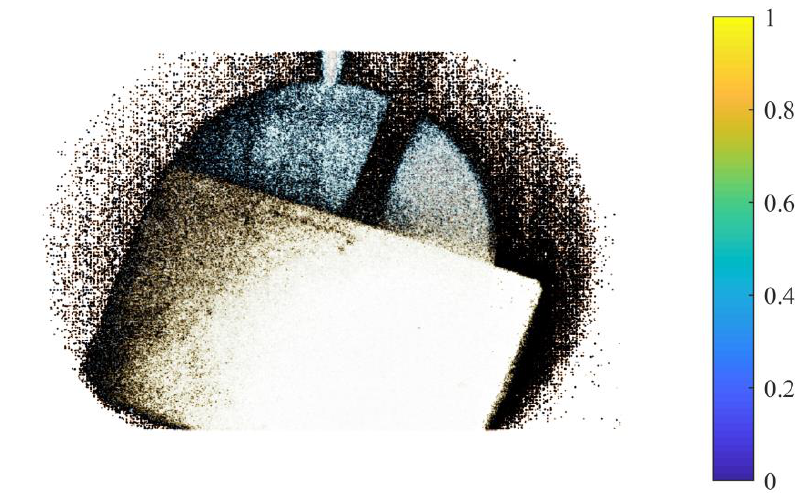
Figure 10. The SSIM figure between Figure